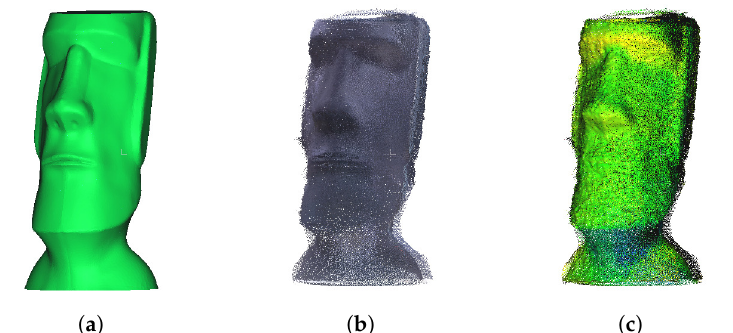
Figure 15. Calibration and registration result of the Moai statue ( a ) original 3D model, ( b ) after calibration, ( c ) superimposition of ( a , b ).